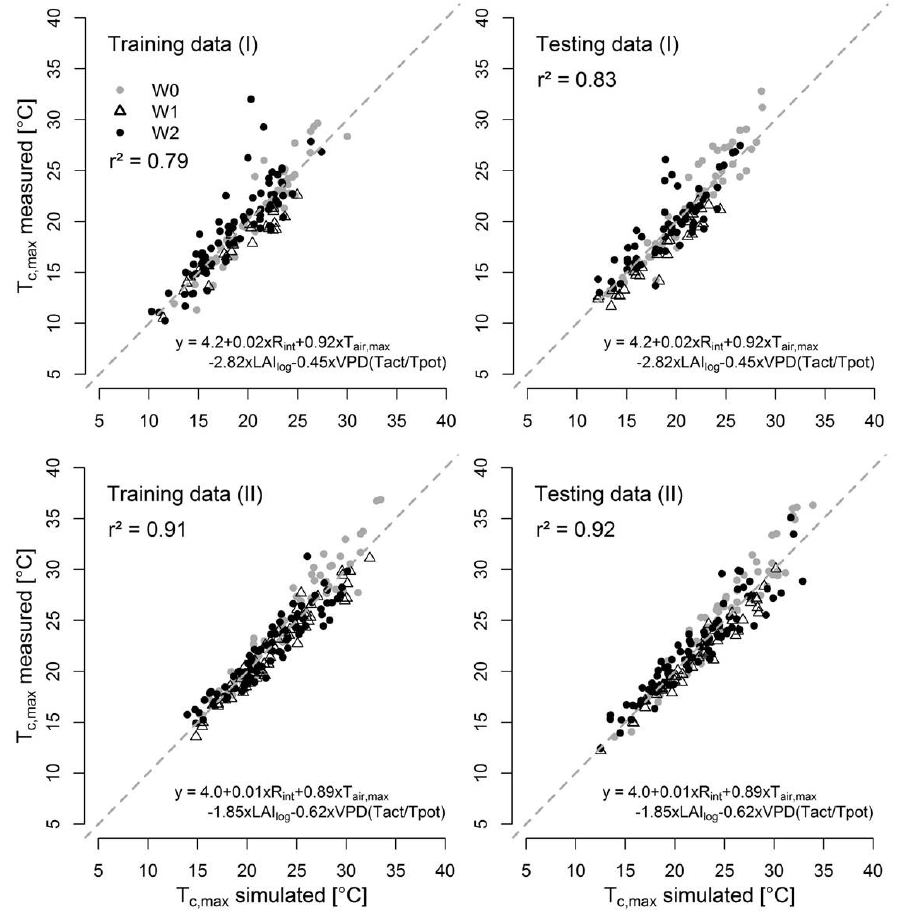
Figure 5. Scatter plot of the measured and the simulated maximum daily canopy temperatures (T c,max ) for the training and the testing data set during the pre ‐ heading (I) and the post ‐ heading phase (II) for all irrigation treatments (W0 = no irrigation, W1 = medium deficit irrigation and W2 = full irrigation). The dashed gray line shows the line of identity. Equations of the multiple linear regression models and r 2 (= coefficient of determination) are given (abbreviations as for Tables 2–4).